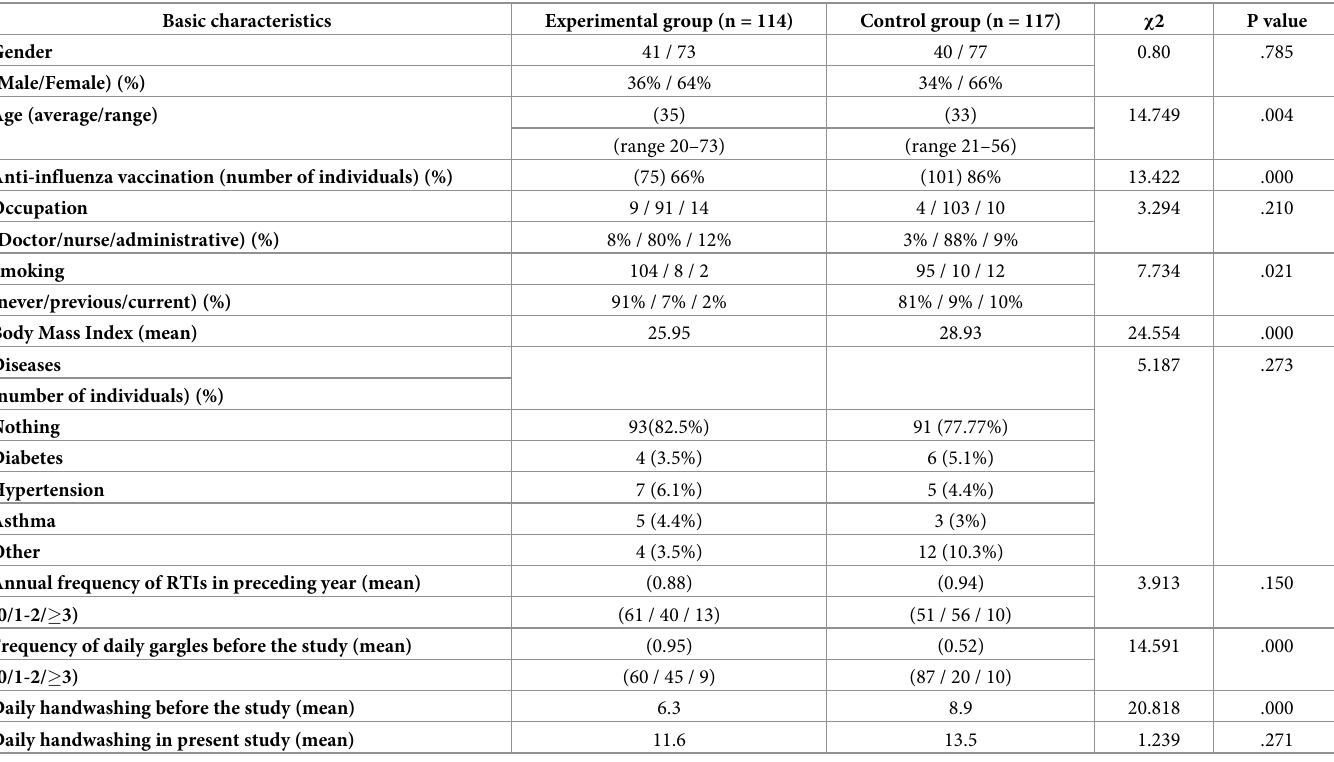
Table 1. Characteristics of the experimental and control